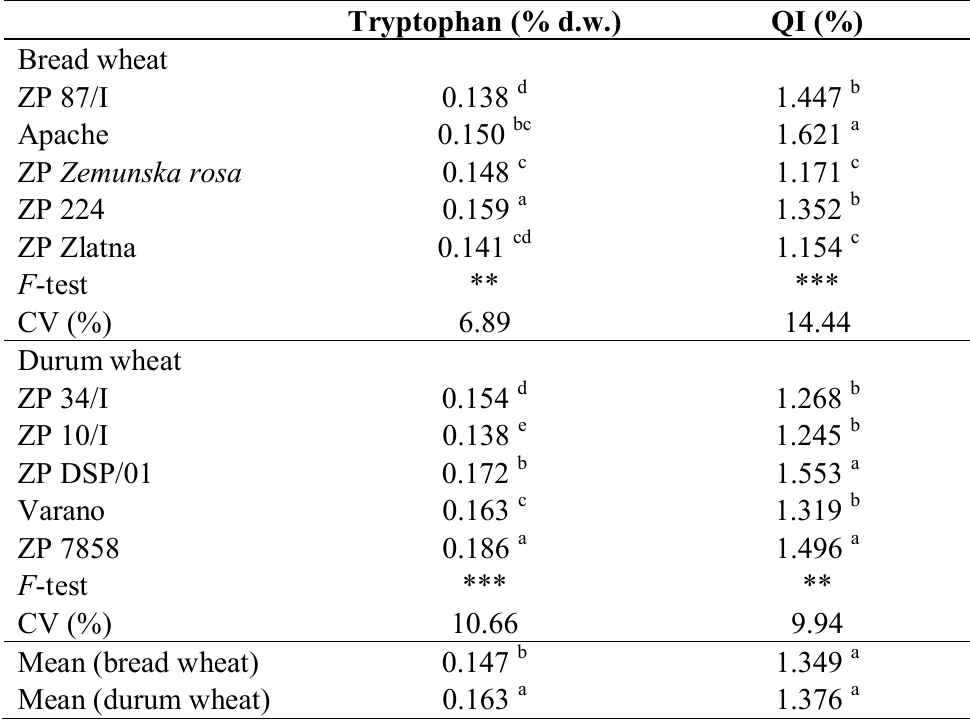
Table 5. Content of tryptophan and protein quality index in grains of different bread and durum wheat